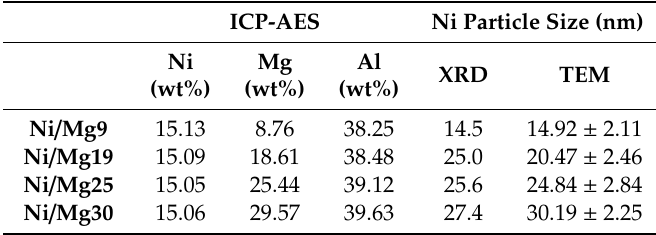
Table 1. ICP-AES analysis and the Ni particle sizes evaluated by XRD and